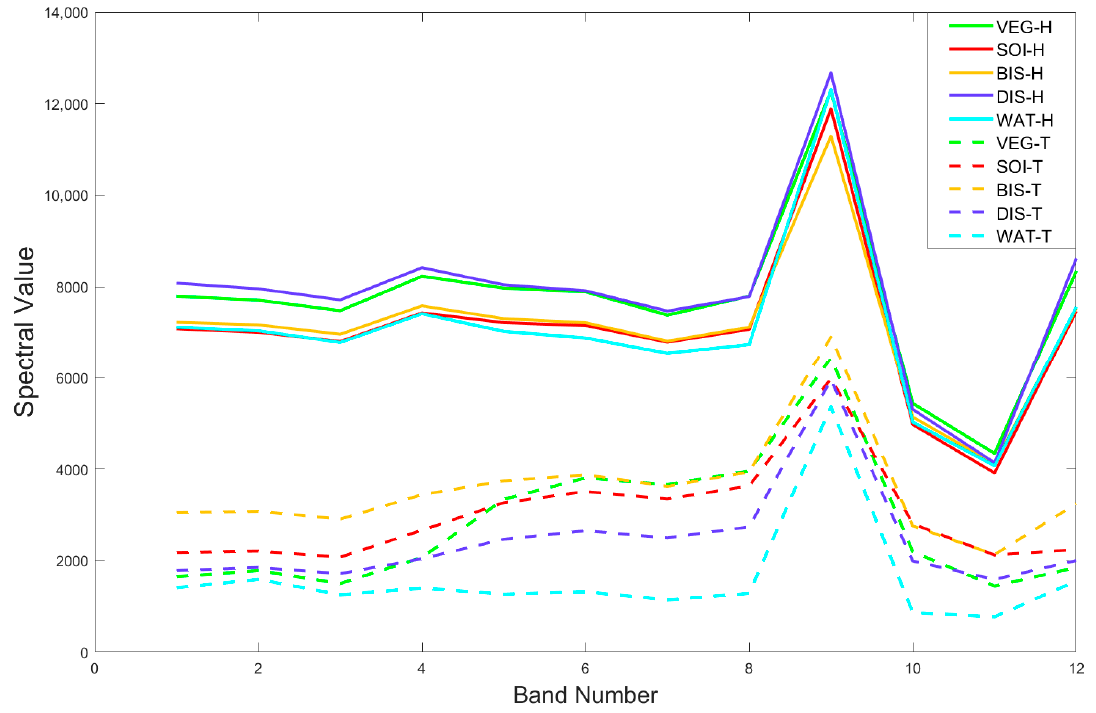
Figure 8. The spectral values of five land cover samples covered by “thin cirrus” and “high-probability clouds” in 12 bands.